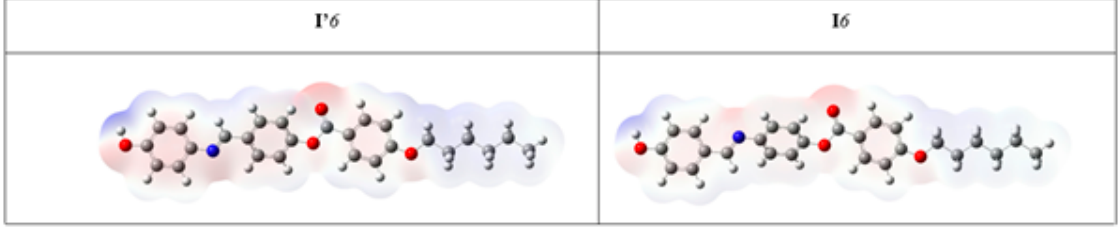
Figure 6. MEP calculated at B3LYP/6-31G(d.p) for the isomer I 6 .